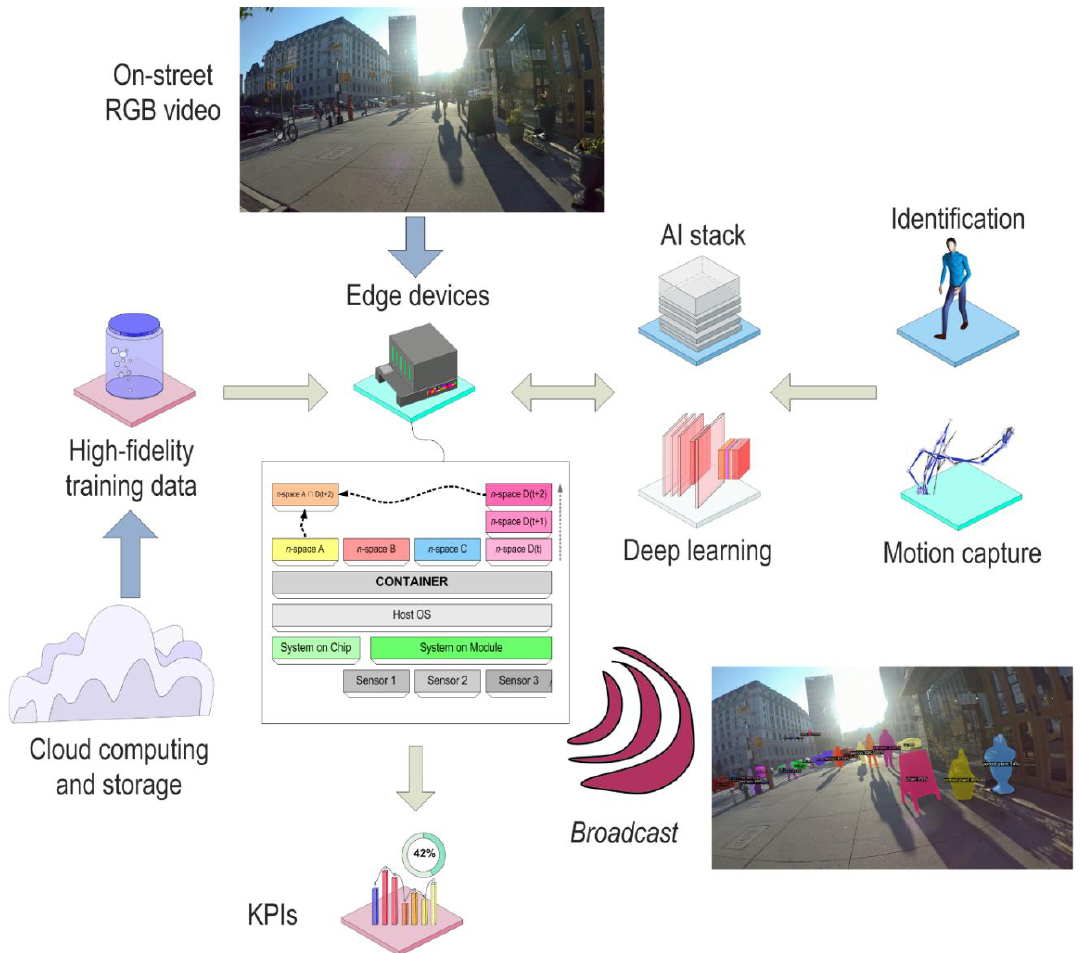
Figure 8. Our Wi-Edge implementation of an outdoors street-side pedestrian identification and censusing.